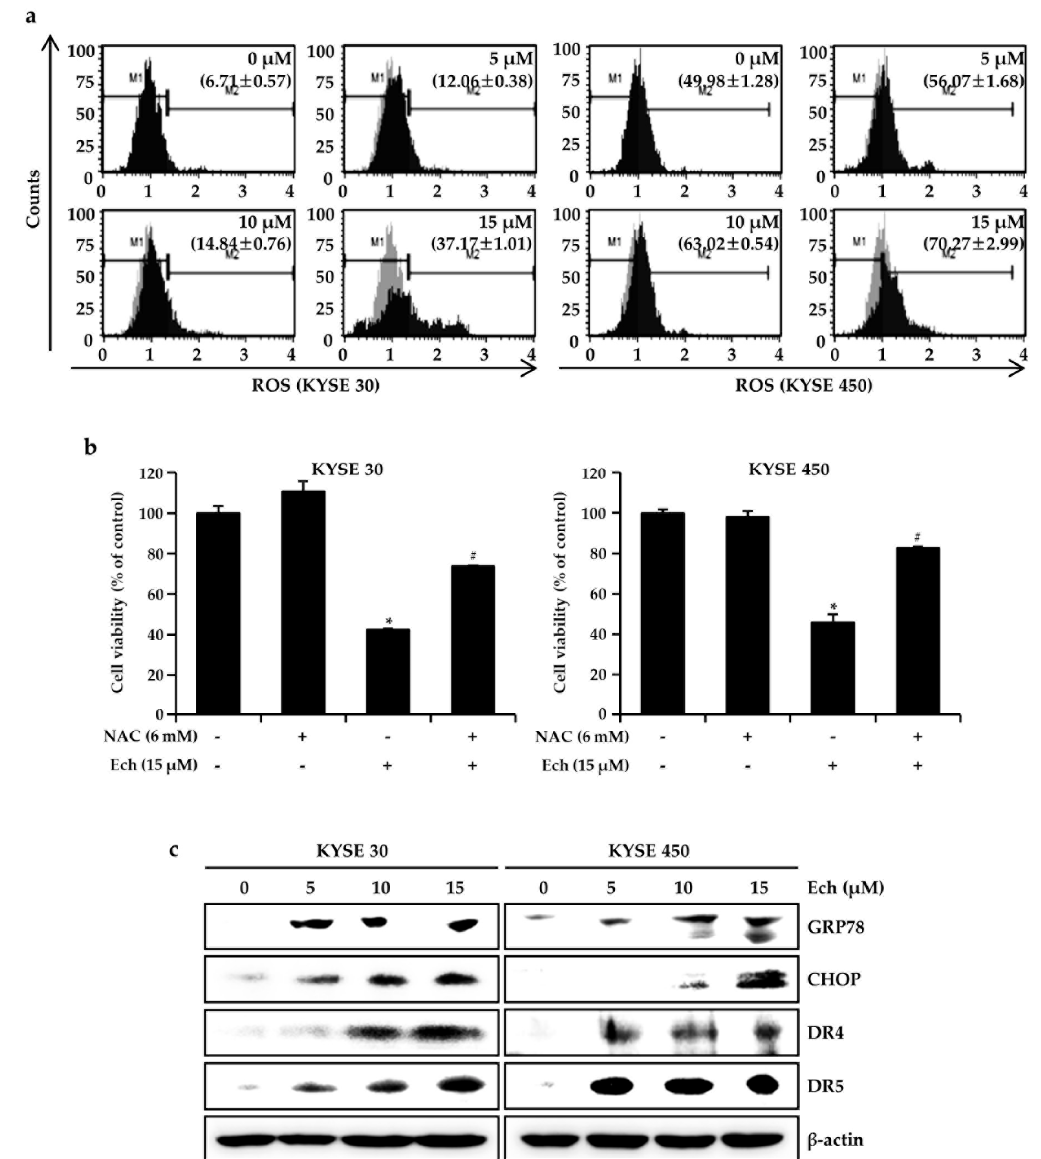
Figure 4. Effects of Ech on intracellular ROS induction. ( a ) Ech induced ROS formation in ESCC cells. ROS formation was measured with a Muse™ Cell Analyzer (materials and method). M1 refers to the fraction of ROS negative population while M2 refers to the region of ROS positive population. Average percentages of ROS positive cells are shown in the M2 region. ( b ) NAC rescued Ech induced cell death through ROS scavenging. Cells were pretreated with 6 mM NAC for 3 h and then exposed to 15 µ M Ech for 48 h. Data are presented as mean ± SD of three independent experiments (* p < 0.05 vs. untreated control; # p < 0.05 vs. Ech-treated cells). ( c ) Ech increased ROS-mediated signal proteins. Expression levels of GRP78, CHOP, DR4, and DR5 were determined with Western blot. β -actin was used as a loading control.